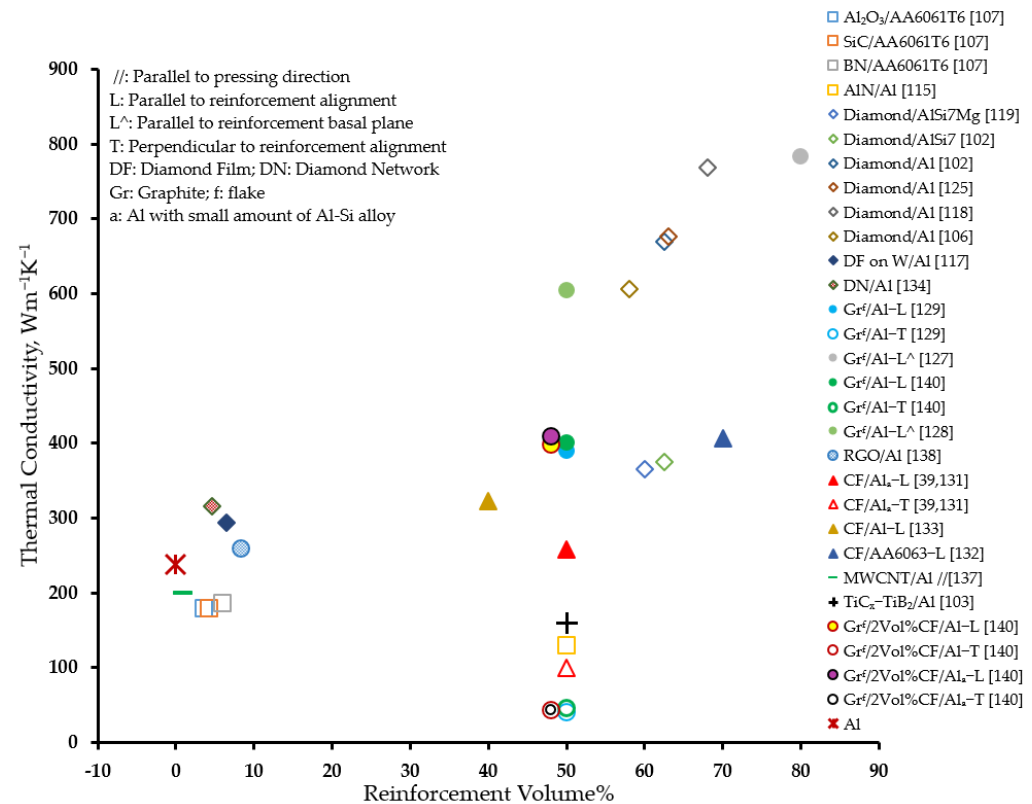
Figure 10. Effect of reinforcement on the thermal conductivity of AMCs.